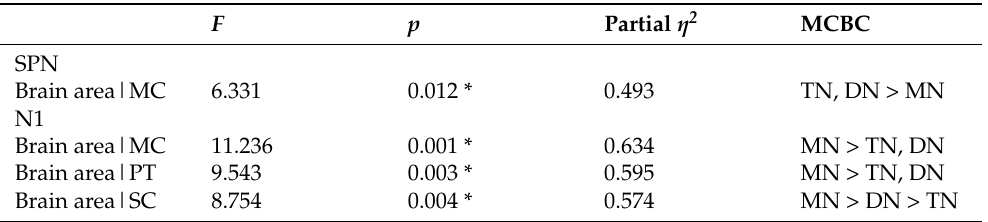
Table 2. Results of simple effect analysis for the amplitudes of N1 for the experiments recruiting voluntary